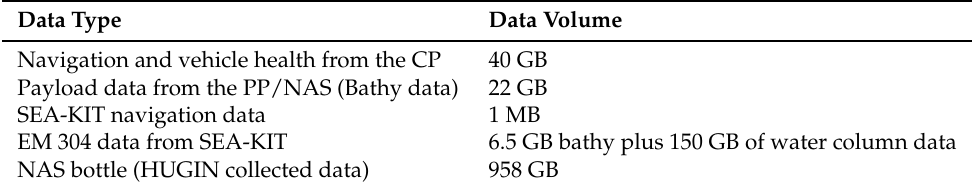
Table 6. Actual data volumes from the 24 h of data collection during Round 2 Field Test in Kalamata, Greece.